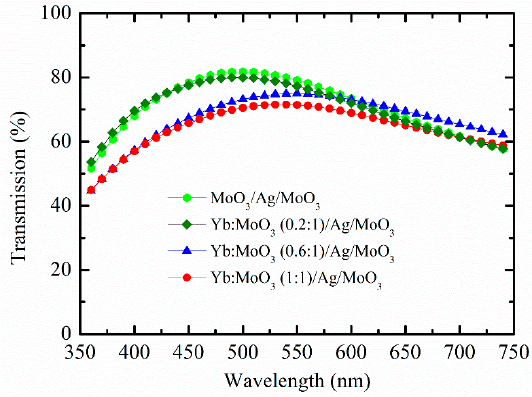
Figure 3. Measured optical transmittance of the DMD multilayers on glass substrate.